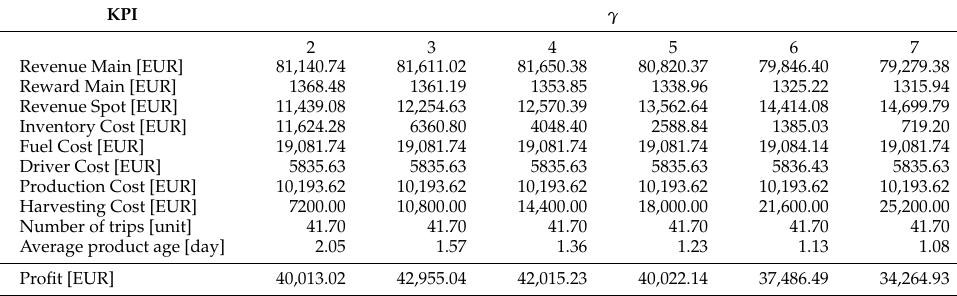
Table 13. Average KPIs for the case of δ = 0.85 (company C 2 ).